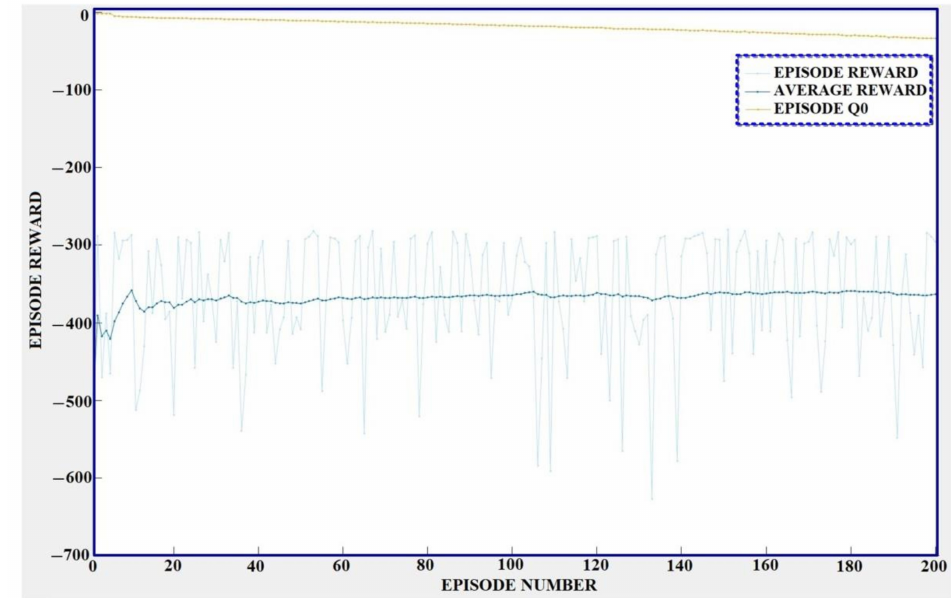
Figure 27. Training stage of the RL-TD3 agent for the correction of u dref , u qref , and i qref